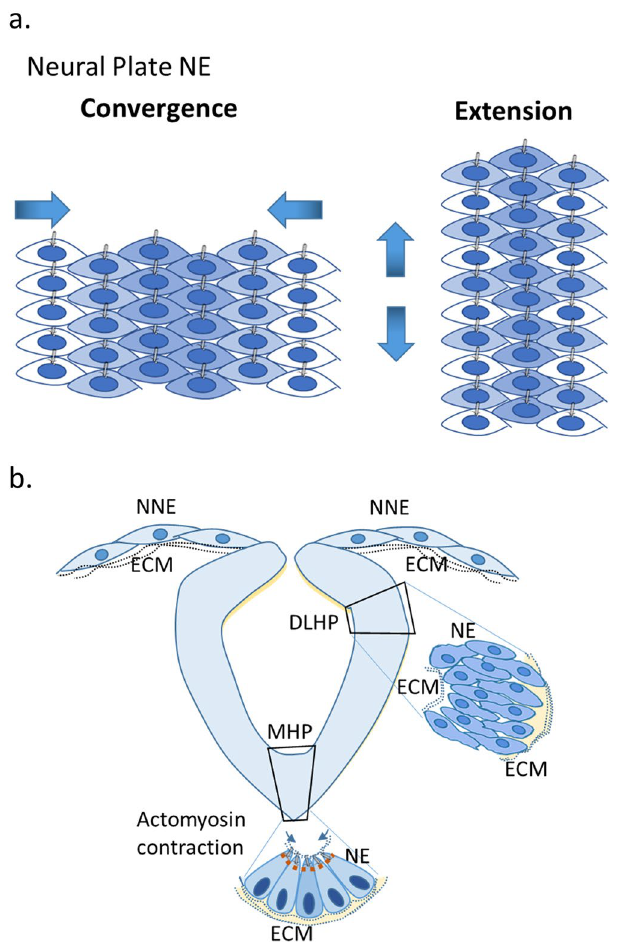
Figure 1. Neural tube formation involves a series of biological processes including mechanochemical signal sensing from the environment to orchestrate cell proliferation, cytoskeleton remodeling, and migration of neural and non-neural ectodermal cells. ( a ) Neural plate cells undergo convergent-extension to facilitate posterior- anterior elongation of the neural tube. Neuroectodermal cells (NE) migrate to the midline in response to extracellular signals received by cilia in NE cells to establish and maintain polarity. ( b ) Midline NE cells undergo apical constriction via a biological process involving actomyosin cytoskeleton remodeling to form the midline hinge point (MHP). NE cell and non-neuroectodermal (NNE) cells continue proliferation and migration during the neural tube closing process upon sensing signals in the extracellular matrix (ECM). NE cells at the dorsolateral hinge point (DLHP) undergo proliferation, migration dorsally, and reshaping to form the DLHP bringing the NE/NNE edges at the dorsal midline together. Advancing migration and proliferation of NNE and mesenchymal cells facilitate ectodermal layer extension when dorsal midline cells’ protrusions meet and join at the closing point. The process also brings NE cells together to establish cell junctions and close the